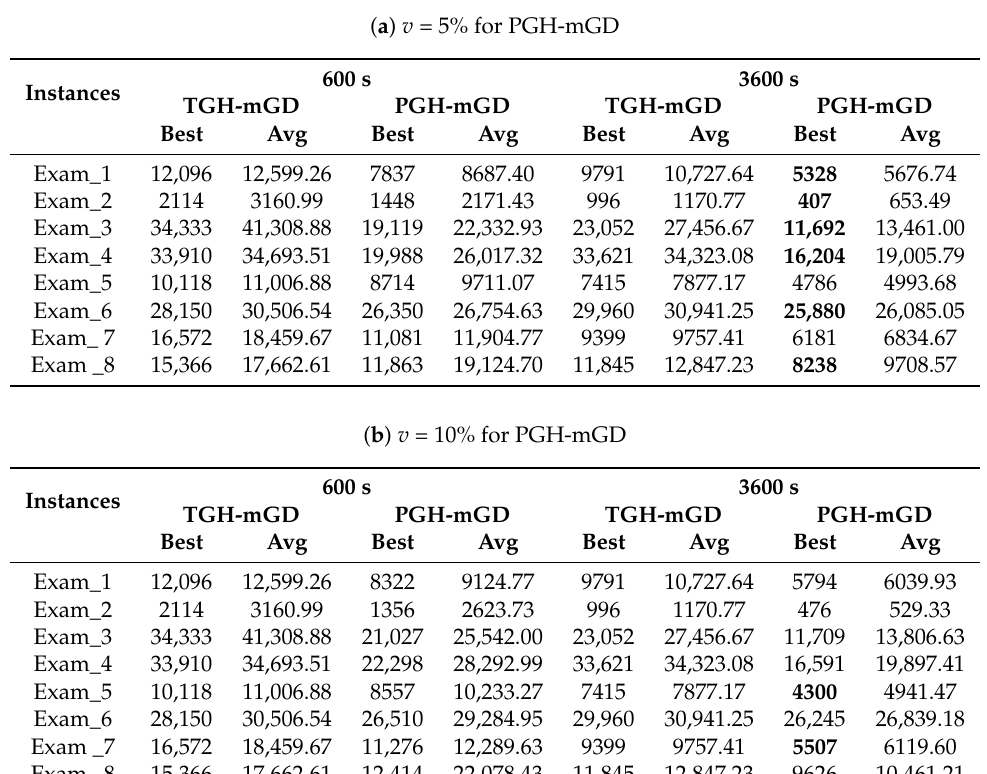
Table 6. Penalty values of ITC2007 exam dataset for different termination criteria.